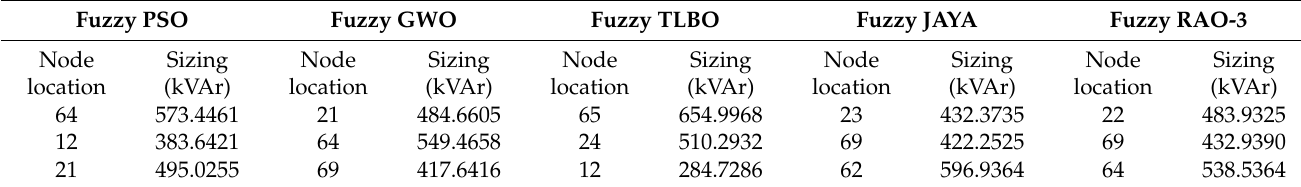
Table 3. DSTATCOM optimum location and